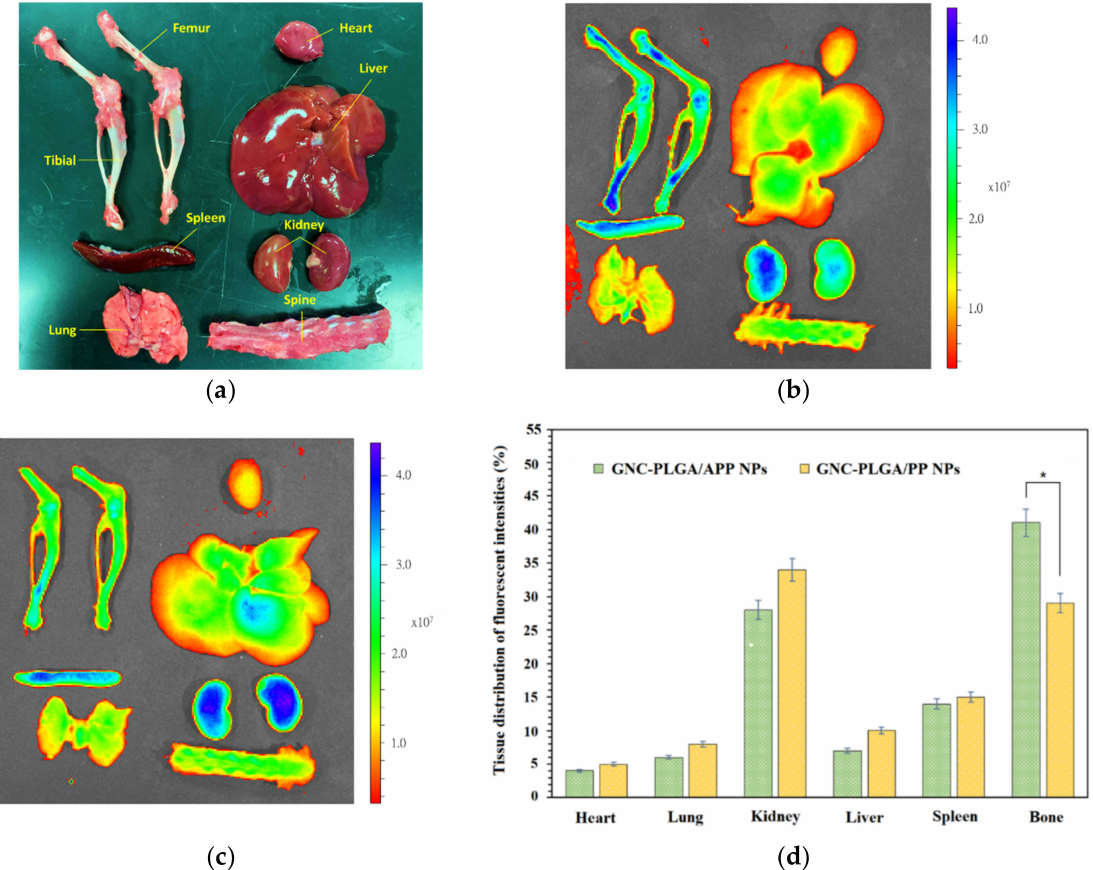
Figure 6. The distribution and fluorescence quantification in vivo were evaluated after 6 h of injection of both nanoparticle groups (GNC-PLGA/APP NPs and GNC-PLGA/PP NPs) into the tail vein of SD rats. Optical photographs of various major tissues (heart, liver, spleen, lung, kidney) and bone (bilateral femur/tibia, and spine) of SD rats ( a ) and fluorescence images of GNC-PLGA/APP NPs ( b ) and GNC-PLGA/PP NPs ( c ) were taken for the major tissues. Fluorescence quantitative results of the major tissues are shown in ( d ). These results represent the means ± SDs ( n = 3). (*) indicate significant differences of p <